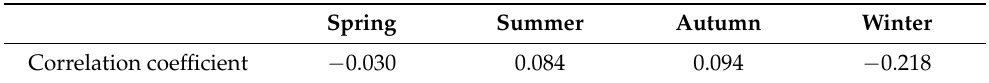
Table 3. Seasonal correlation between AOD and the PM 2.5 concentration.